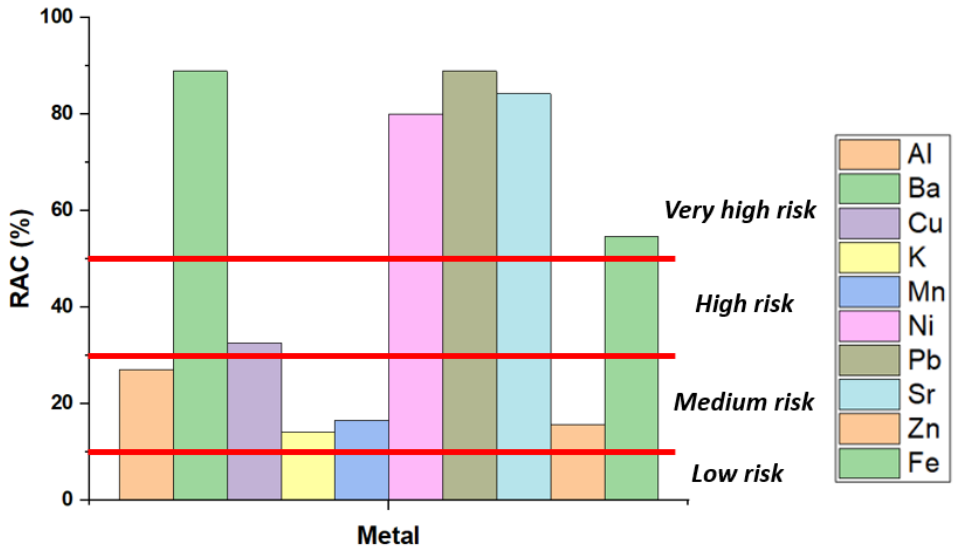
Figure 7. RAC index comparison of metals in the BS sample.